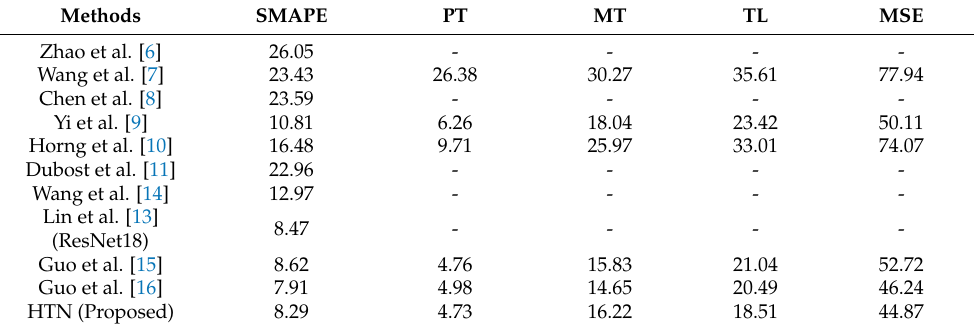
Table 4. Comparison with state-of-the-art methods on the public AASCE MICCAI 2019 challenge